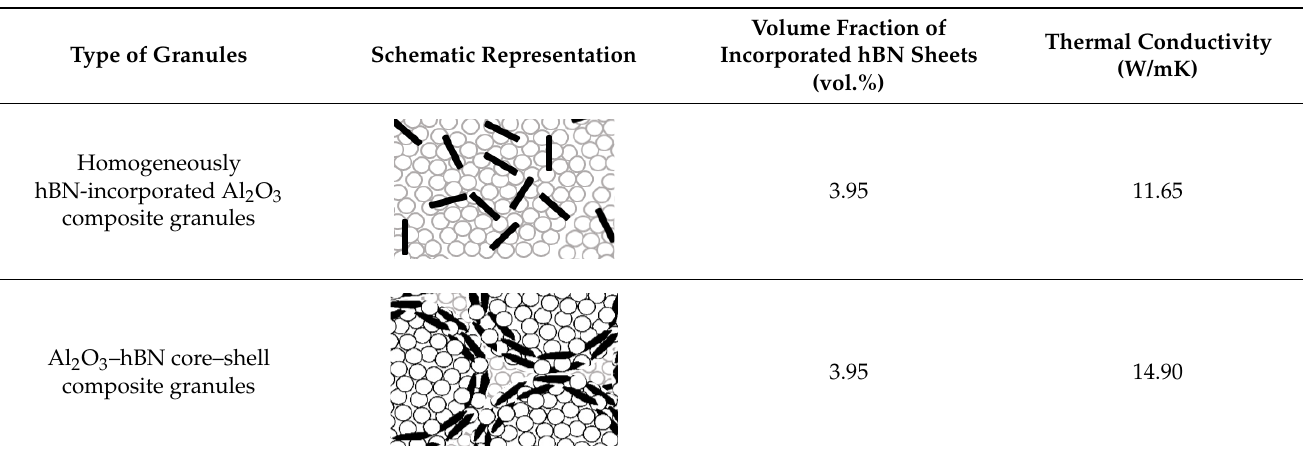
Table 1. Comparison of the thermal conductivity of sintered artifacts obtained using two different types of Al 2 O 3 – hBN composites granules.